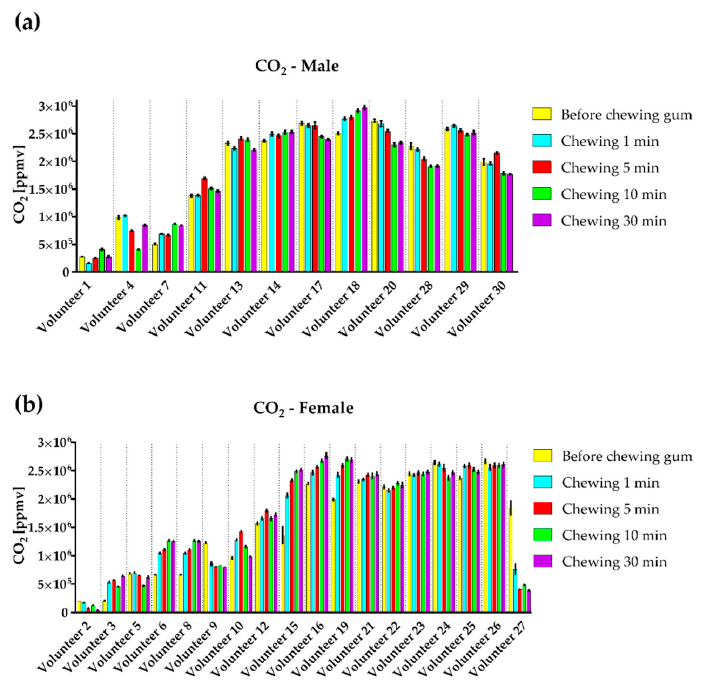
Figure 5. Results of CO 2 measurements for each volunteer ( a ) male; ( b ) female.